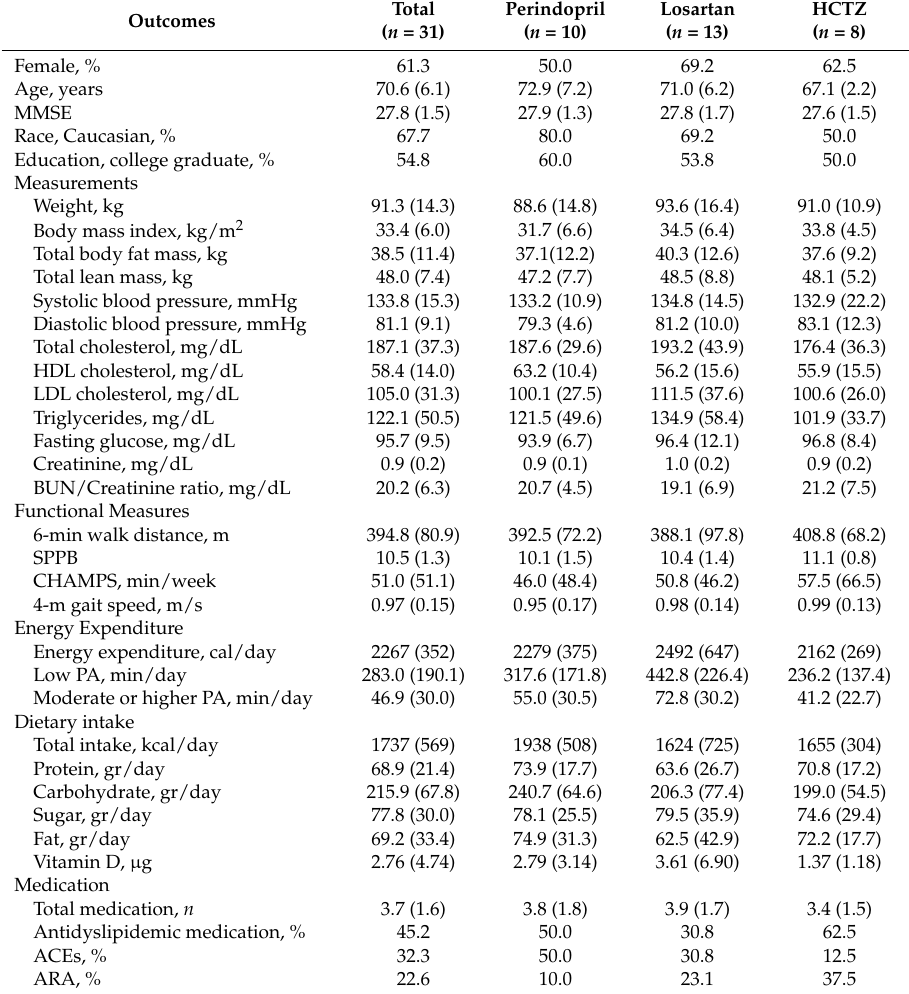
Table 1. Baseline characteristics of the study sample according to the randomization